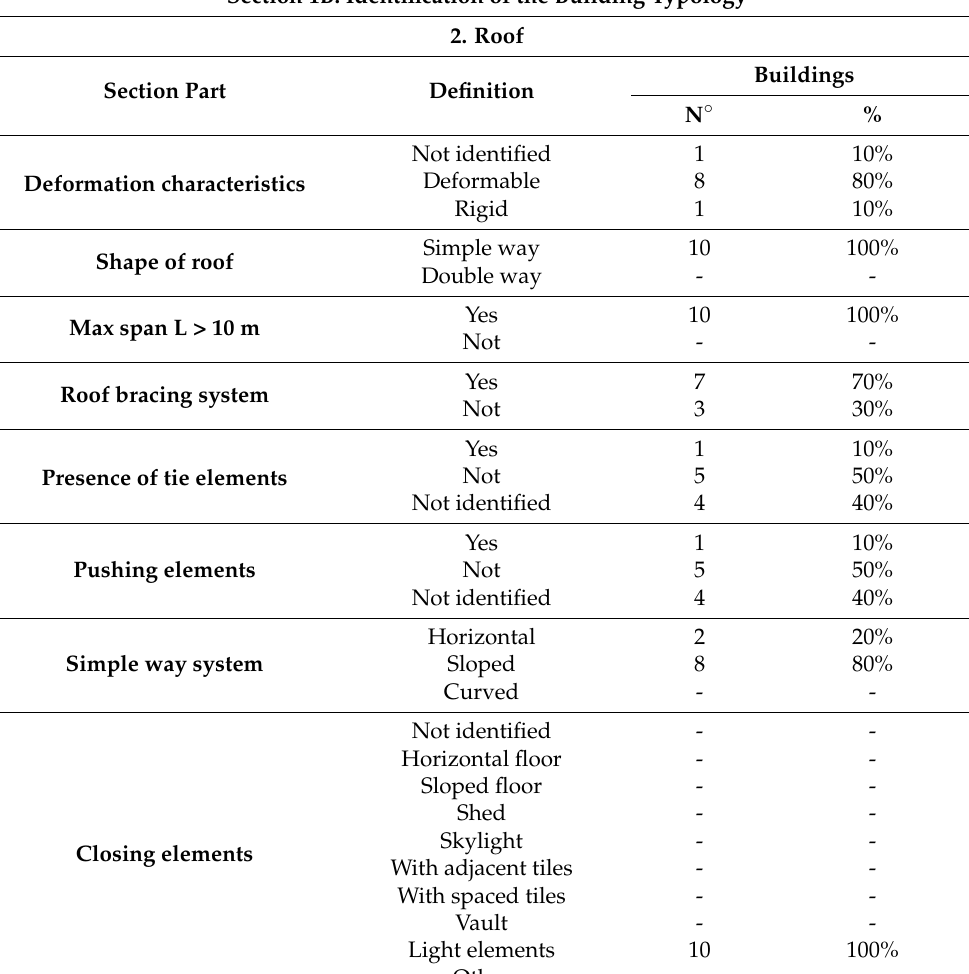
Table 6. Section 1B CARTIS-Building. Case studies characterization: 2. Roof: Simple way system: main member typology—Synoptic panel.